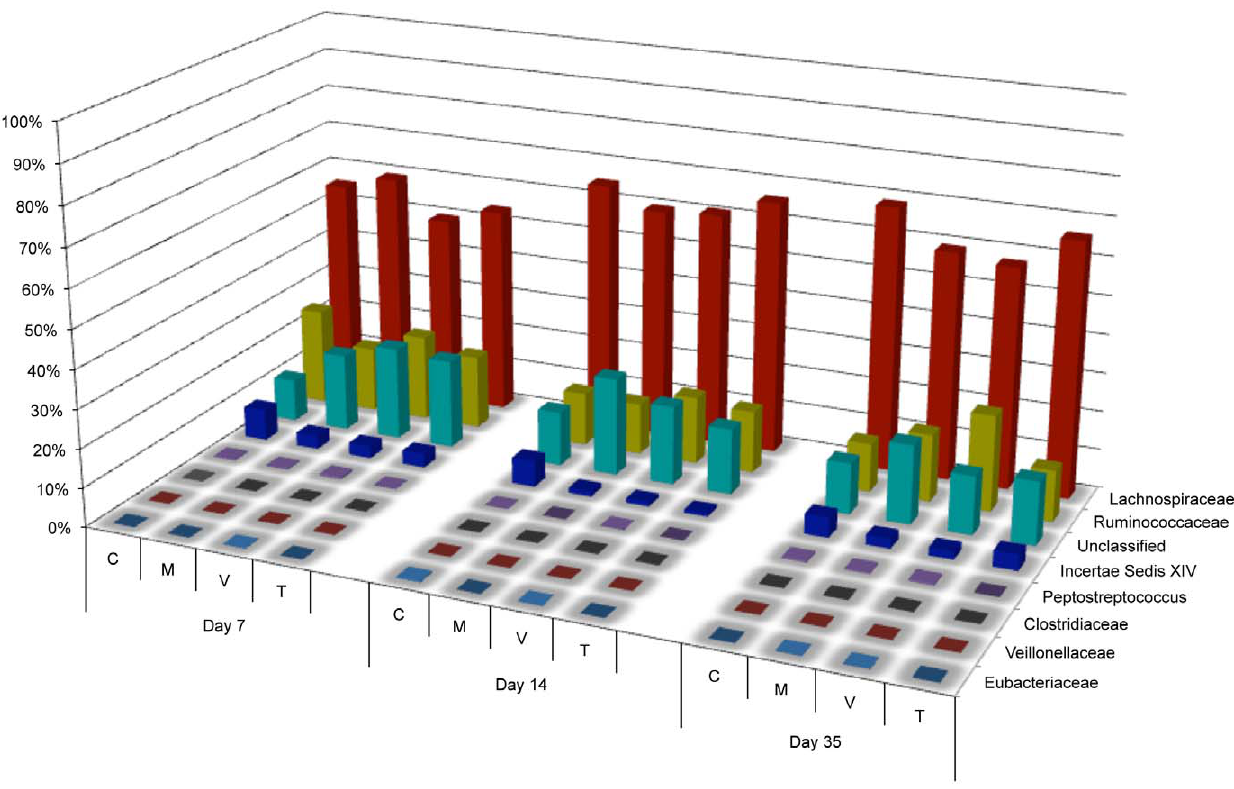
Figure 3. Bacterial family distribution within the Firmicutes phylum at the three timepoints after the start of treatment using V3 amplicon sequencing (n=53,588). For each timepoint, C = control diet, M = monensin treatment, V = monensin/virginiamycin treatment, and T = monensin/tylosin treatment.